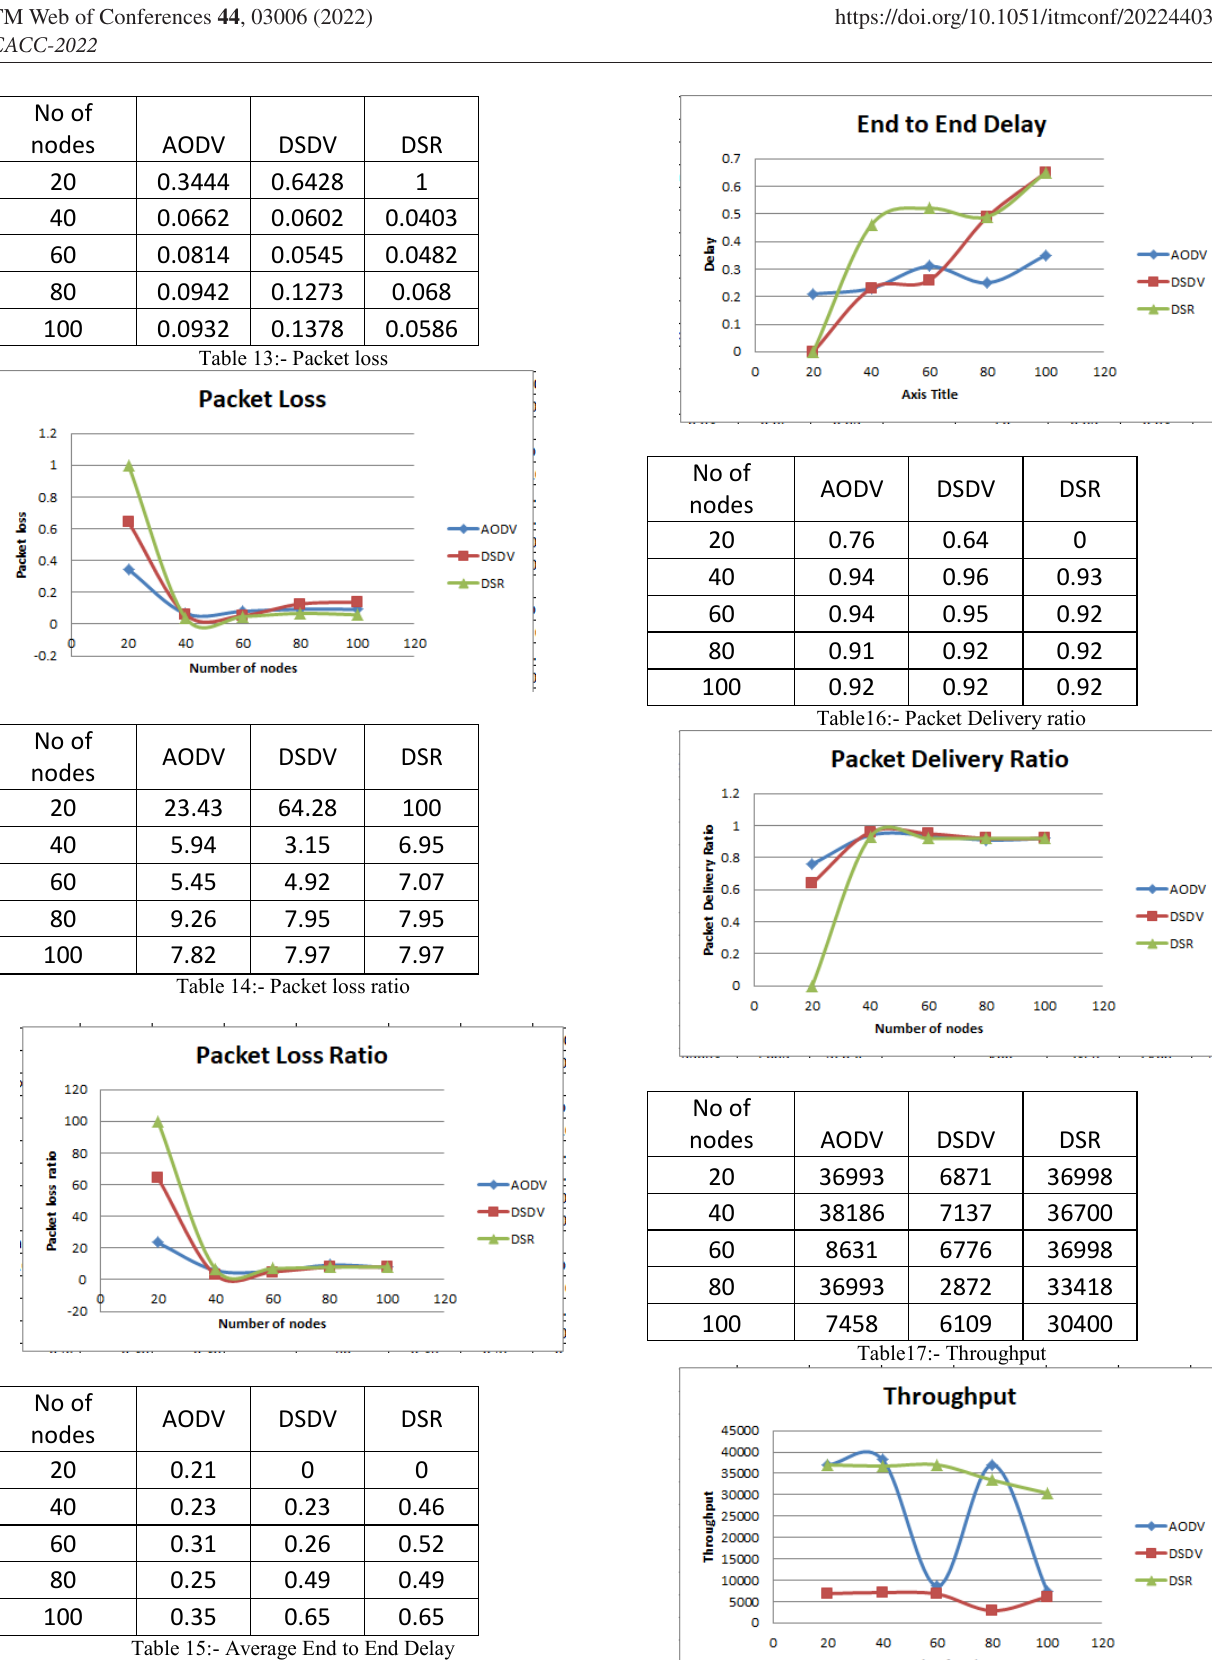
Table 15:- Average End to End Delay